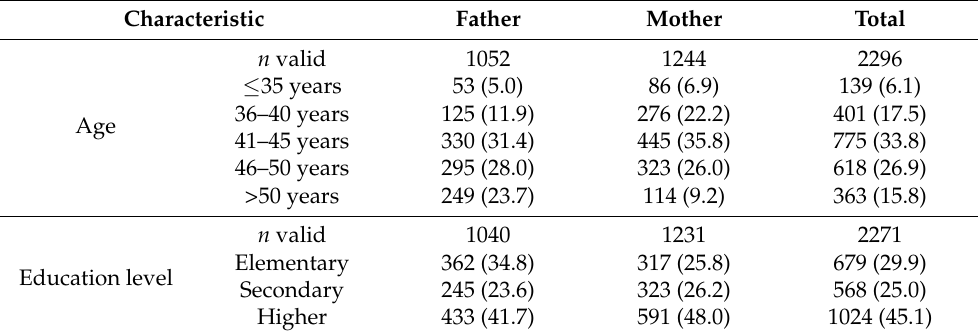
Table 1. Sociodemographic characteristics of the parents participating in the study ( N = 2296). Characteristic